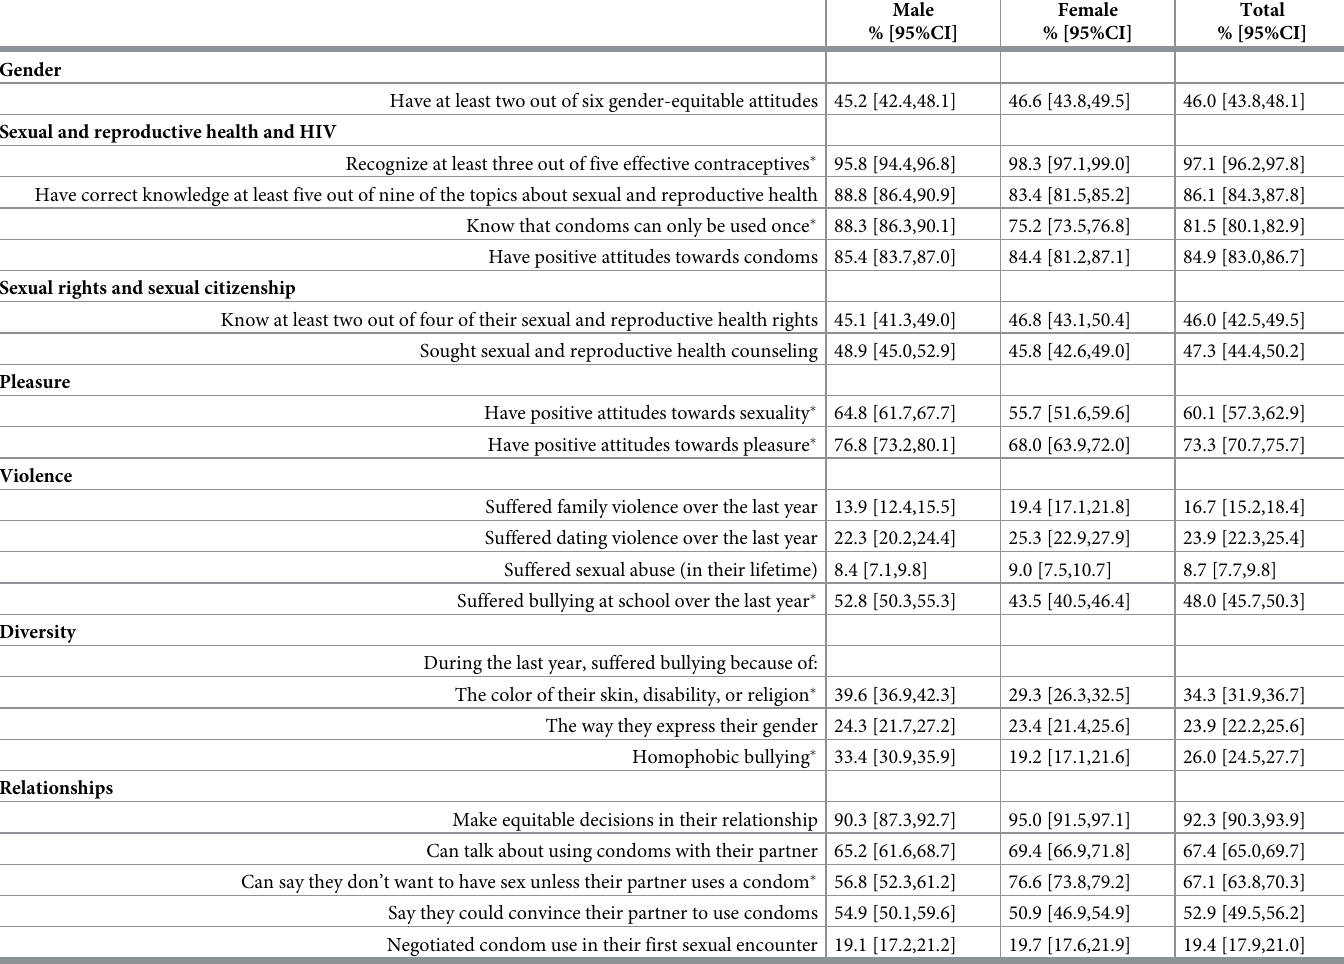
Male Female Total % [95%CI] % [95%CI] % [95%CI]